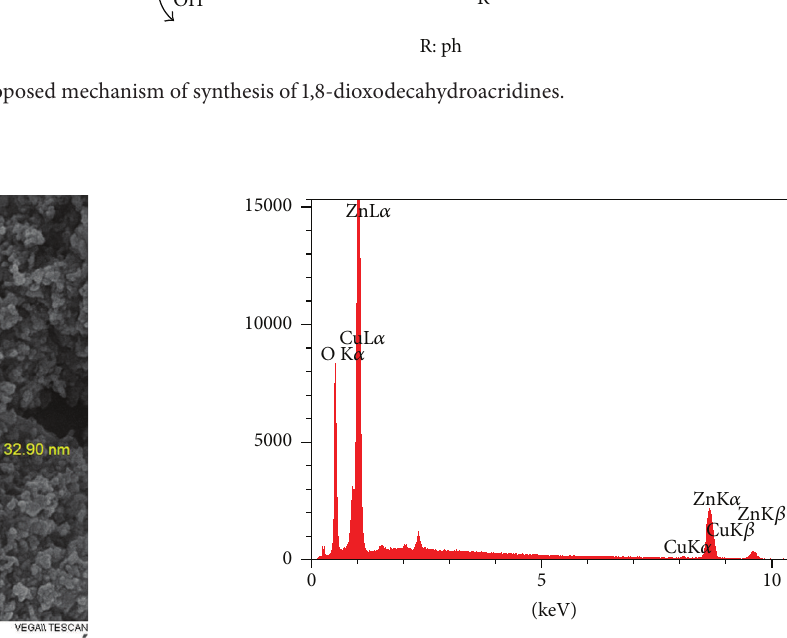
Figure 2: Representative EDX spectra of 1% Cu-doped nanocatalyst